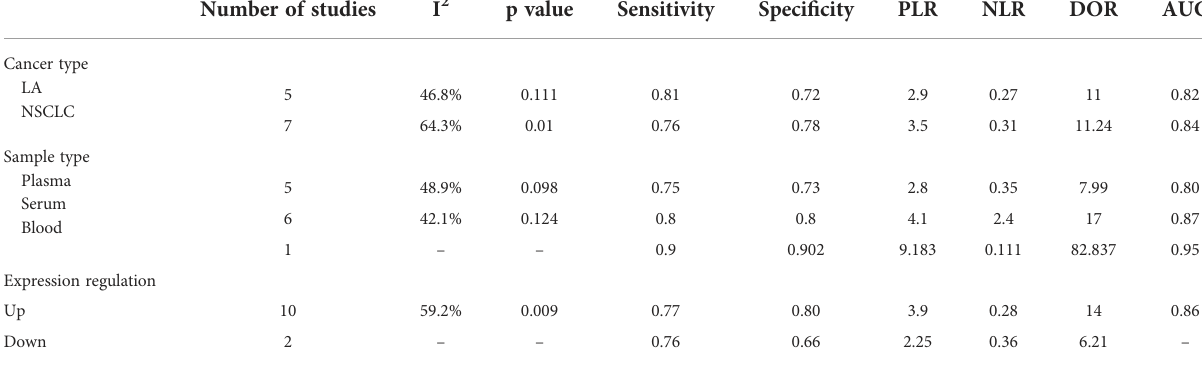
TABLE 3 Subgroup analysis of NSCLC